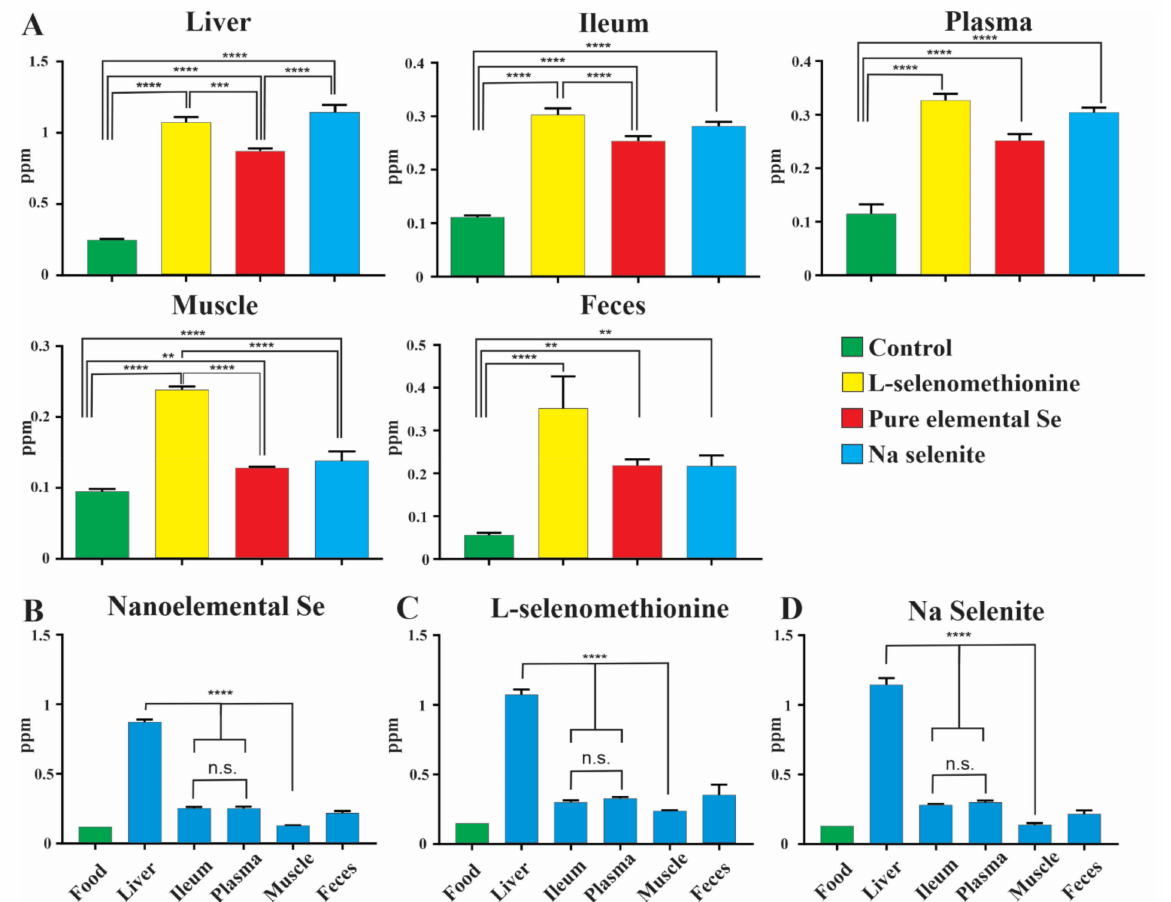
Figure 2. ( A ): Comparison of levels of Se in liver, ileum, plasma, muscle and feces when fed different Se diet formulations for 5 weeks at 0.15 parts per million (ppm) measured by mass spectrophotometry. ( B – D ): Comparison of Se concentrations between liver, ileum, plasma, muscle and feces in animals fed a nanoelemental Se, L-selenomethionine and Na Selenite diet at 0.15 ppm for 5 week ( n = 6 animals for tissues and feces; food, n = 1). Statistically significant increases in bioavailability of Se are observed in all diet formulations. One-way ANOVA was carried out with Tukey’s multiple comparisons between groups. Data is presented as mean ± SEM, n.s.: not statistically significant, p < 0.01 **, p < 0.001 ***, p < 0.0001